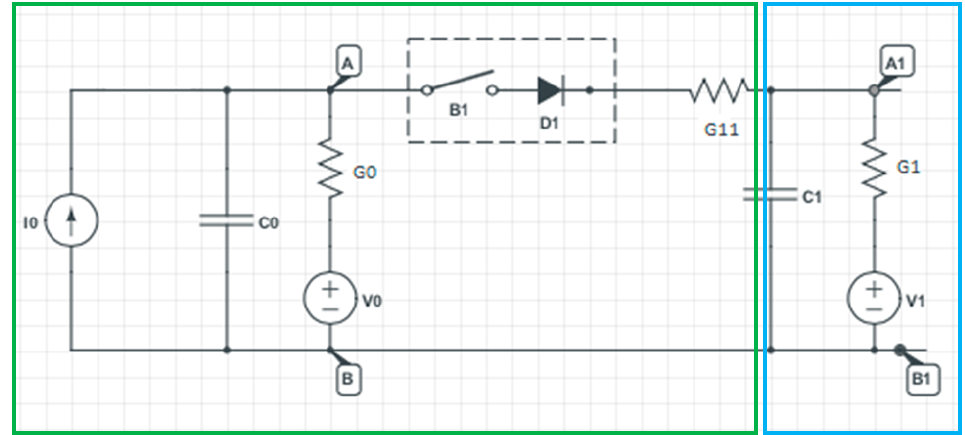
Figure 2. The proposed equivalent electrical circuit of the Smart Polygeneration Microgrid (SPM) thermal network (the green line denotes what has been labelled as TR and the blue one is the boundary of the user U).